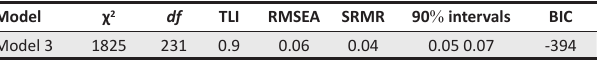
TABLE 4: Dimensionality of the finalised six-factor models. Model χ 2